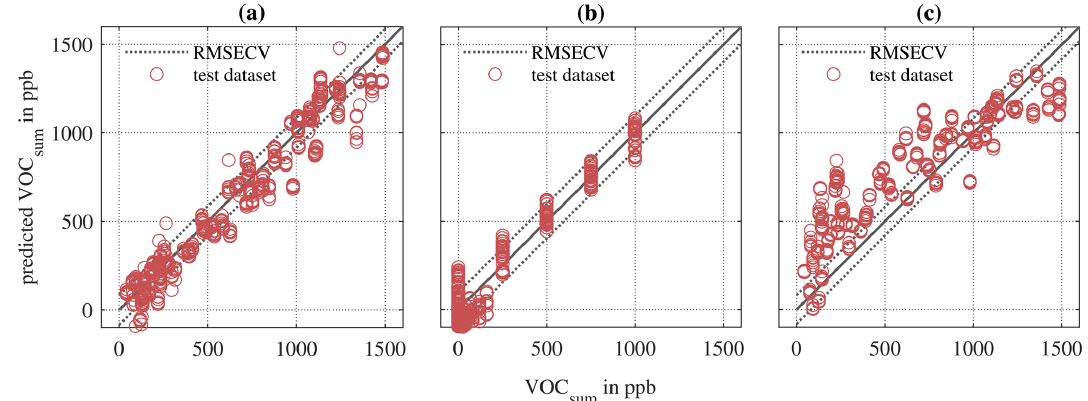
Figure 10. PLSR models for AS-MLV-P2 for quantification of VOC sum in ppb for different training and testing models. (a) Randomized training and testing (Table 4, α ). (b) Randomized training and sequential testing (Table 4, β ). (c) Sequential training and randomized testing (Table 4, δ